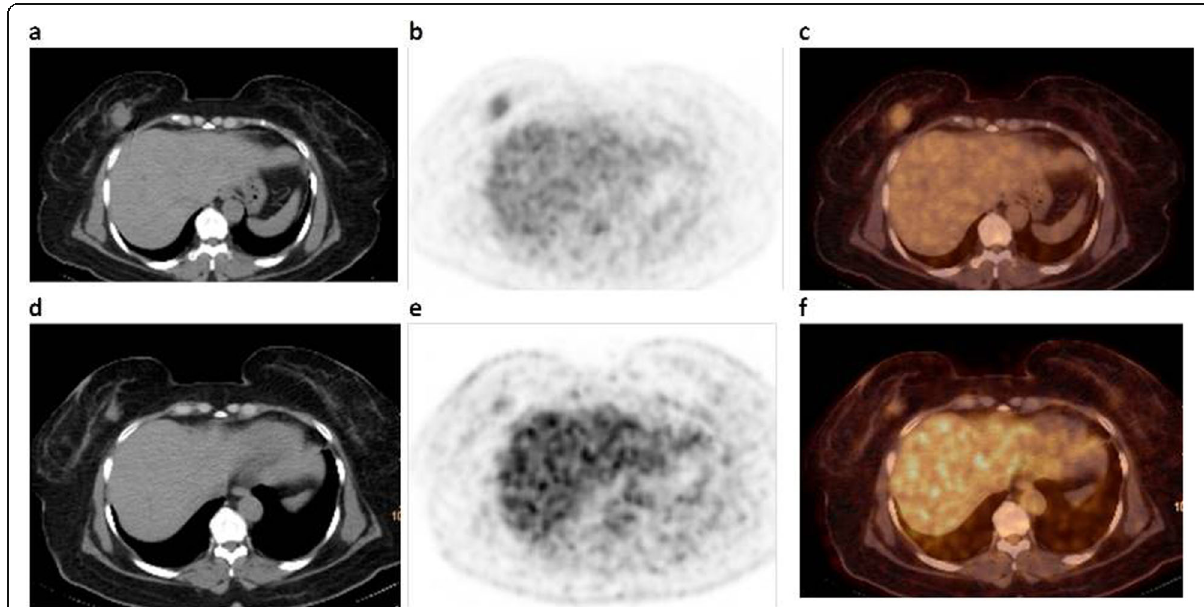
Fig. 4 68 years old female patient presented with right breast lump biopsy revealed invasive duct carcinoma grade II (luminal A subtype). Axial CECT image ( a ) revealed a rather defined right breast soft tissue mass lesion measuring about 29 × 36 mm at lower inner quadrant that was eliciting increased tracer uptake reaching 5 SUL peak in axial PET ( b ) and fused PET/CT ( c ) images. On follow-up after completion of chemotherapy, morphologic and metabolic regression of the mass was noted in the form of reduction in size (reaching 9 × 16 mm) in axial CECT image ( d ) denoting partial response and reduction in SUL peak (reaching 2.1) in axial PET ( e ) and fused PET/CT ( f ) images denoting partial metabolic response